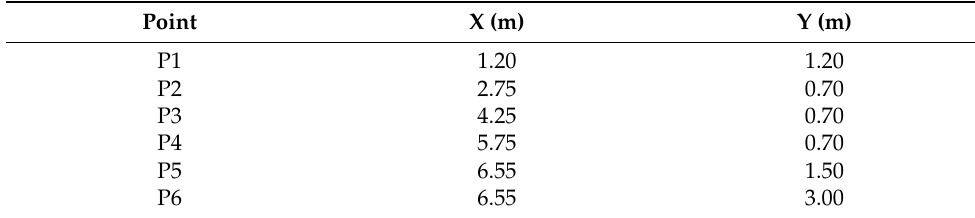
Table 1. Dam-break flow in a 90 ◦ curved channel: location of six measured points.